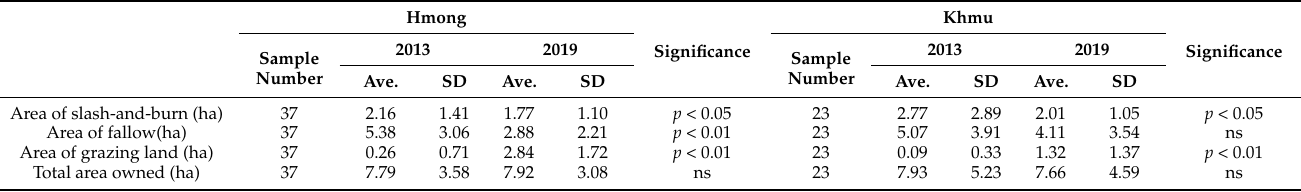
Table 3. Average areas (ha) of land-use rights with standard deviation (SD) owned by the Hmong and Khmu ethnic groups.